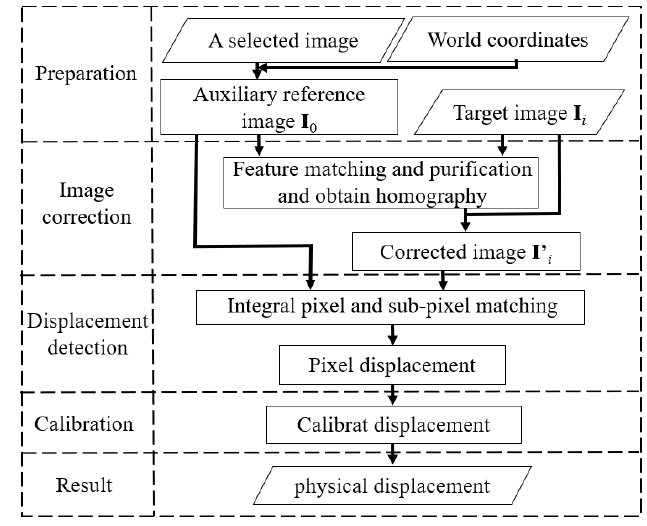
Figure 6. Procedure of the proposed method.